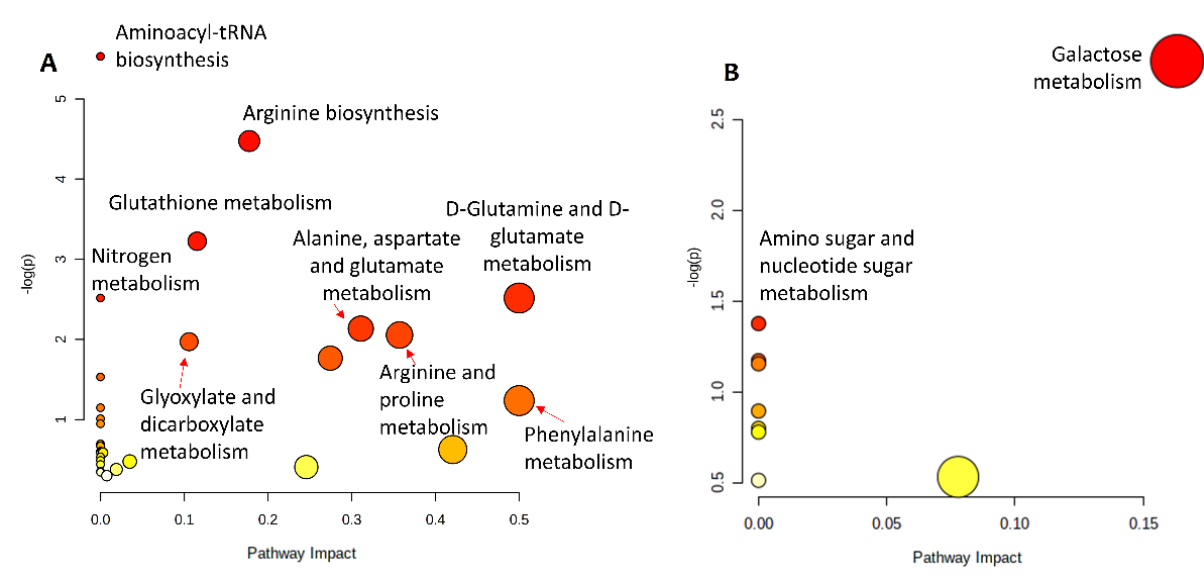
Figure 4. Metabolic systems map summarizing results of the metabolite-set enrichment pathways analysis. ( A ) Model I relevant metabolites; ( B ) Model II relevant metabolites. Only pathways with a p -value < 0.05 were described in the figure. Full lists of the pathways were reported in Tables S2 and S3.